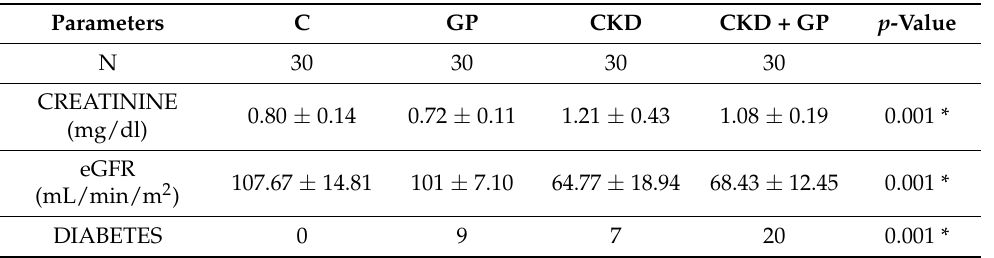
Table 4. Intergroup comparison of biochemical parameters assessed among C, GP, CKD, and CKD + GP Groups.